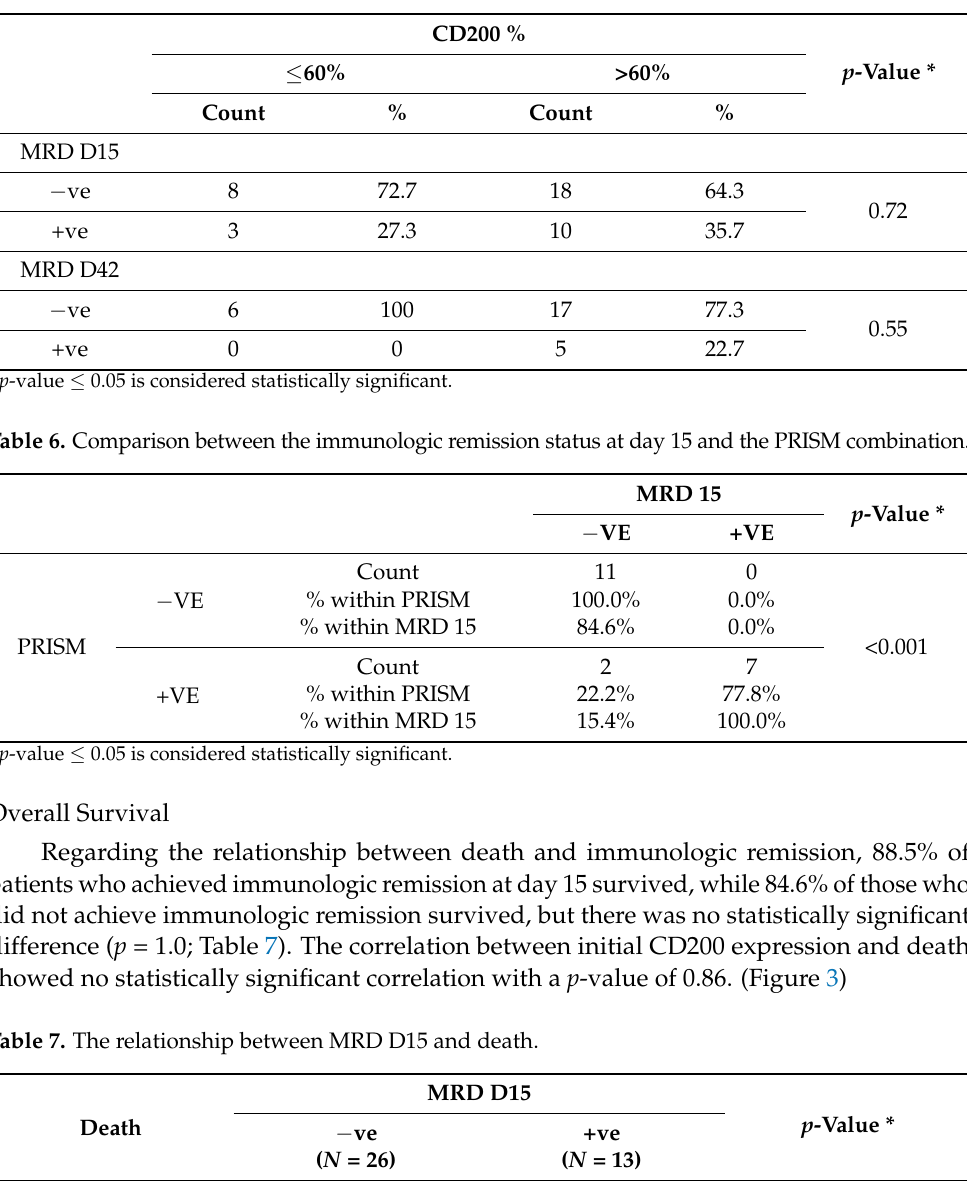
Table 5. Comparison of the immunologic remission status on days 15 and 42 between patients with initial CD200 expression levels ( ≤ 60% and >60%).